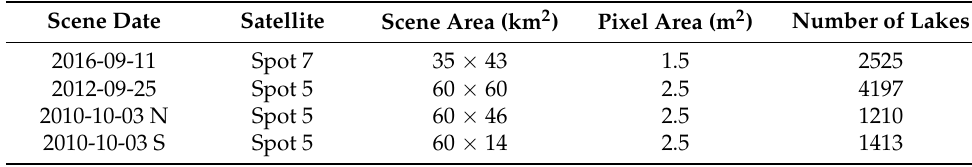
Table 1. Description of scenes used for full training. The ‘number of lakes’ was determined by a combination of automatic polygon generation and manual